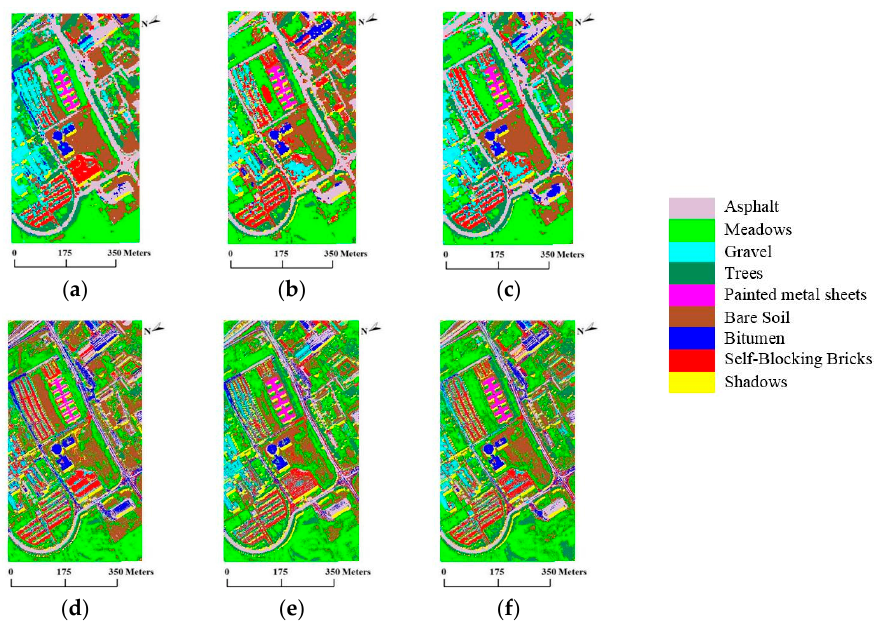
Figure 8. Classification maps for all of the methods with the ROSIS Pavia University dataset using 5, 10 and 15 labeled samples per class. ( a ) TT_AL_MSH_MKE ( L = 5); ( b ) TT_AL_MSH_MKE ( L = 10); ( c ) TT_AL_MSH_MKE ( L = 15); ( d ) TT_MKE ( L = 5); ( e ) TT_MKE ( L = 10); ( f ) TT_MKE ( L = 15).